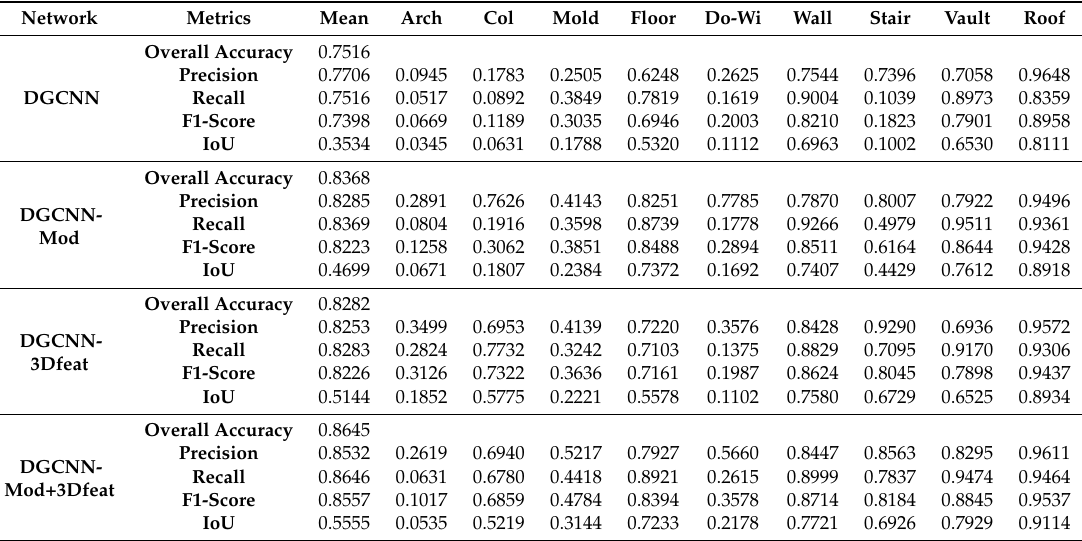
Table A4. Tests performed on the A_SMV scene, with the whole ArCH dataset as training. Fourteen scenes as training, 1 for validation (5_SMV_chapel_1) and 1 for test.